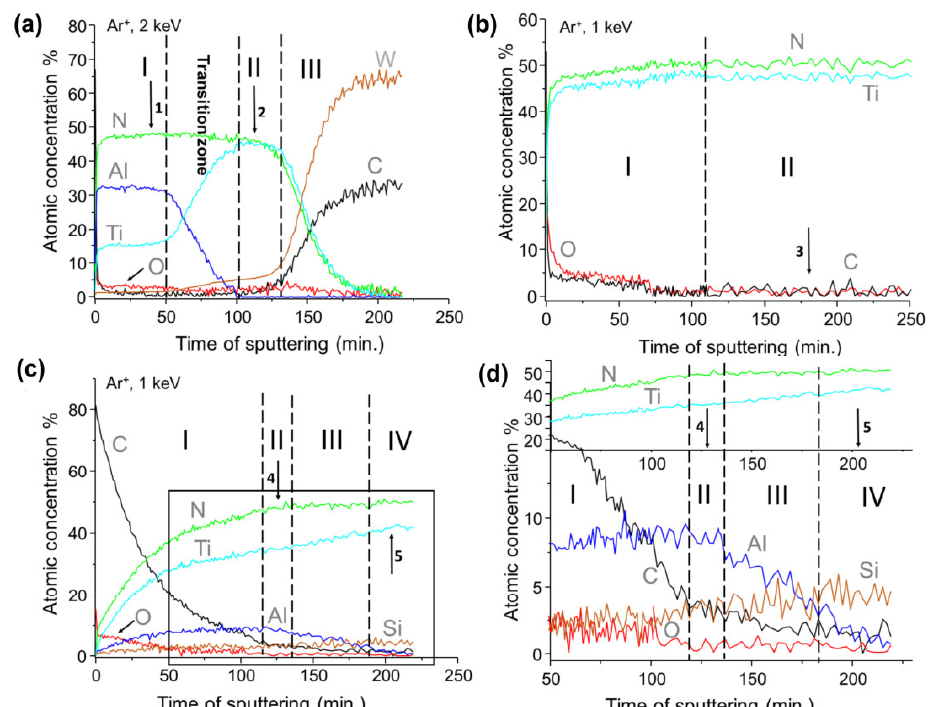
Figure 10. The depth profile analysis of the TiN/AlTiN ( a ), TiN ( b ) and TiAlSiN ( c ) coatings. The enlarged region of the depth profile of TiAlSiN was shown in figure ( d ). The arrows indicate points in the depth profile where the core lines were chosen to analysis. Areas of the ion treatment marked with Roman numerals are described in the manuscript. Table 3. Chemical composition of the tested coatings obtained from collection analysis of the XPS spectra. The averaged results of atomic concentrations calculations given in the table are related to the bolded part of the coatings description.